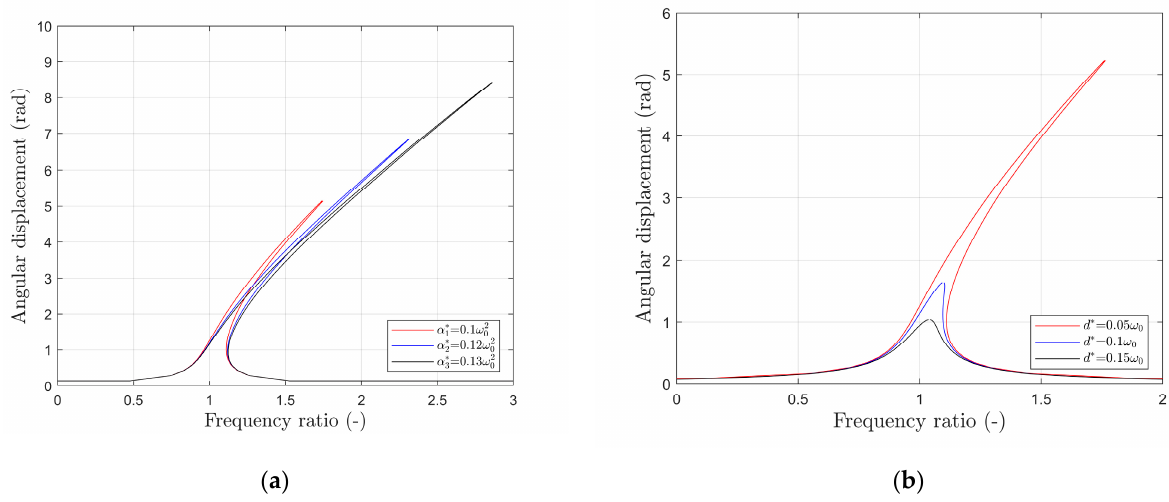
Figure 5. Comparison of frequency-response curves when varying ( a ) the nonlinearity coefficient α ∗ ( d ∗ = 0.05 ω 0 , µ ∗ = 0, ϕ i , j ˆ q = 0.15) and ( b ) the damping coefficient d ∗ ( α ∗ = 0.1 ω 2 , µ ∗ = 0, ϕ i , j ˆ q = 0.15).